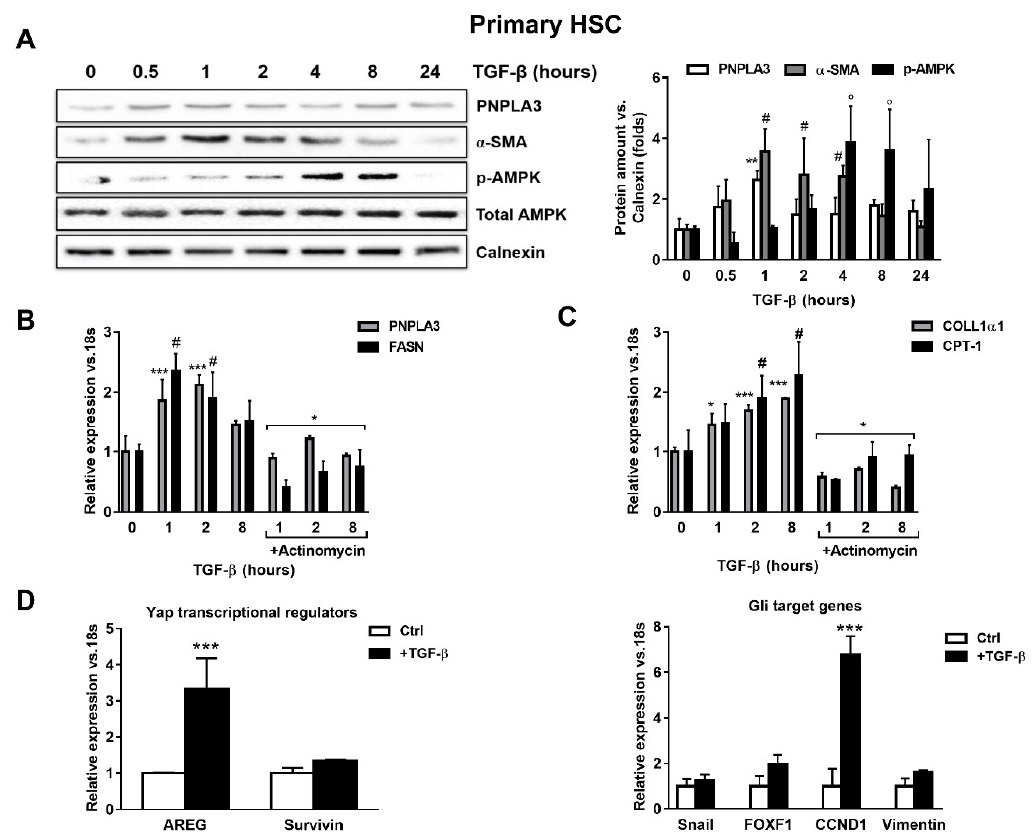
Figure 1. TGF-β increases PNPLA3 and modulates AMPK signaling and Yap/Hedgehog target genes in hepatic stellate cells (HSCs). Primary HSCs (Ctrl) or treated with 5 ng/mL TGF-β at different time points, as indicated in the figure panel. Indicated cells were exposed to Actinomycin for 1h prior TGF- β stimulation. ( A ) Representative blots of PNPLA3, α -SMA, p-AMPK and total AMPK were